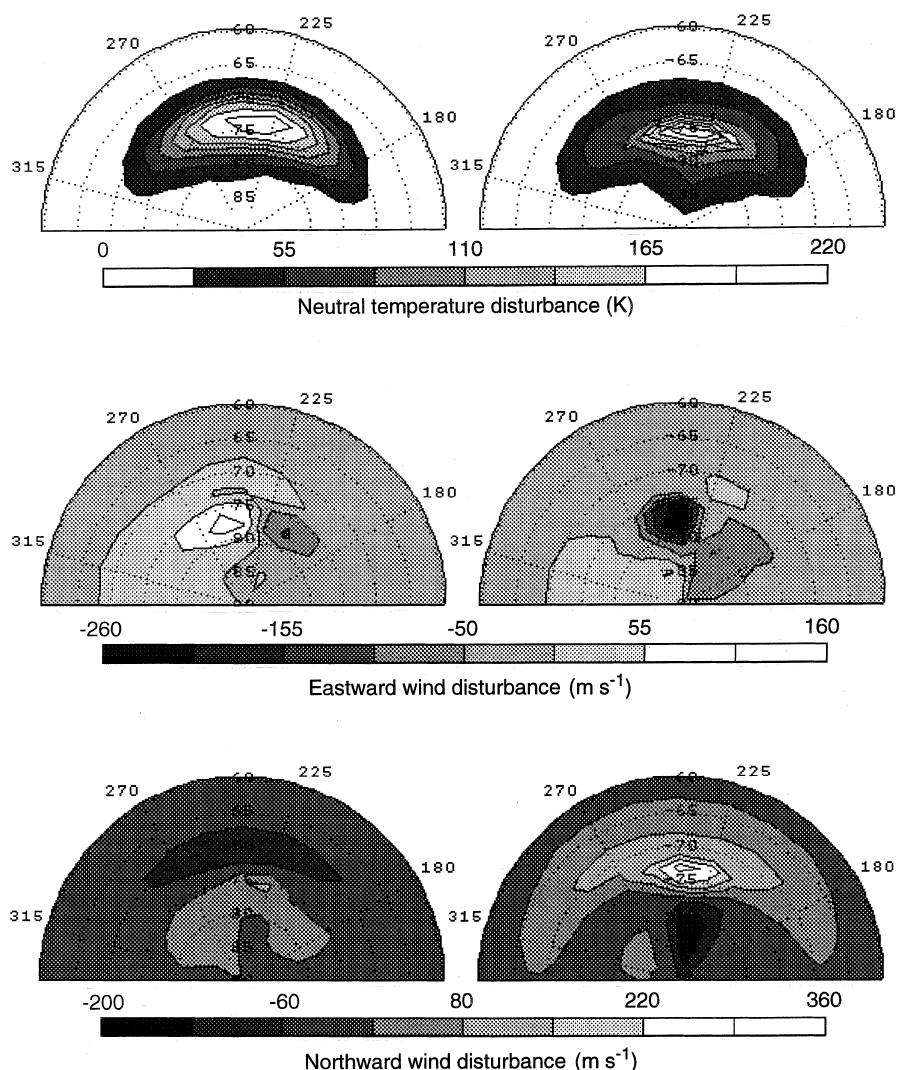
Fig. 6. Geomagnetic polar plots (latitudes 60 (cid:176) –90 (cid:176) ) of the calculated thermospheric disturbances, i.e., the di(cid:128)erences between disturbed and undisturbed values of the calculated thermospheric parameters, at h (cid:136) 300 km in the Northern (summer, left plot ) and Southern seasonal di(cid:128)erences between the e(cid:128)ects caused by the